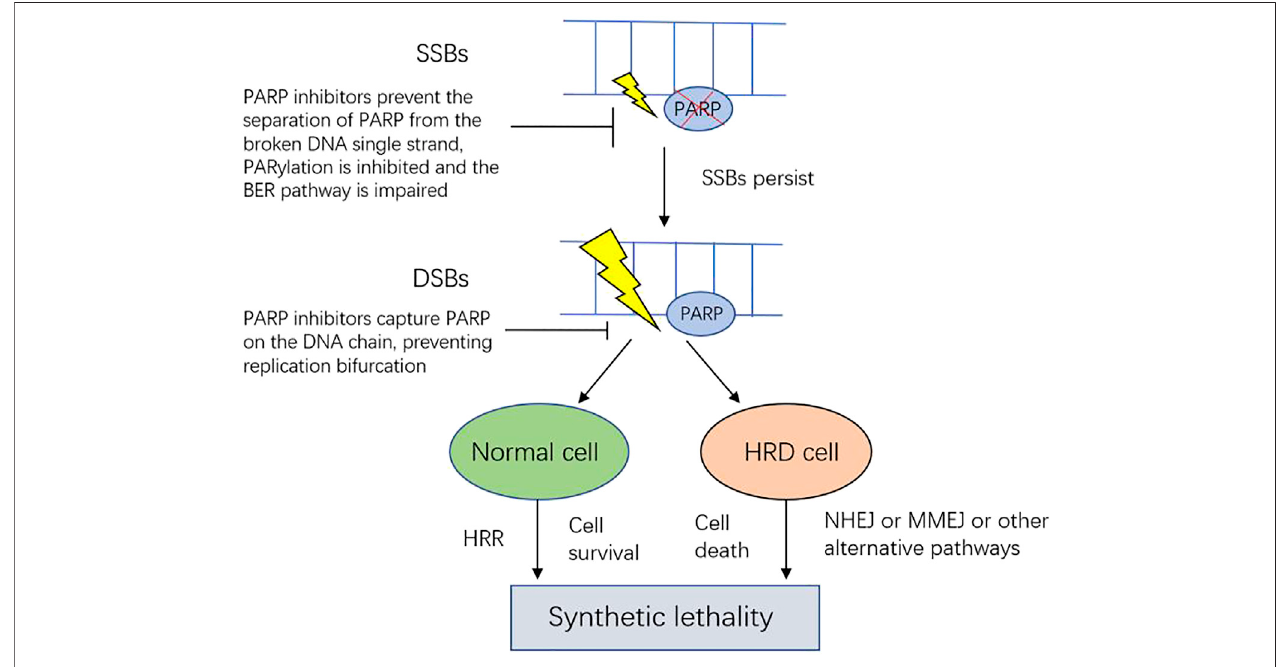
FIGURE2| MechanismofsyntheticlethalitybetweenHRDandPARPinhibitors.SSBsofDNAarenormallyef fi ciently repairedbyBER.PARPinhibitorspreventthe separation of PARP from the broken DNA single strand, PARylation is inhibited and the BER pathway is impaired, SSBs will persist. A replication fork may encounter persistent SSBs during DNA replication, which causes the replication fork to collapse or the formation of DSBs. DSBs are usually repaired by HRR, when some key homologousrecombination genesaredamagedordysregulated,HRDwilloccur.AndthenDNAcannotberequired, orisrepaired byalternativepathwaysthatare highly error prone, which results in gross genomic instability and cell death. SSB: single-strand breaks; DSB: double-strands breaks: BER: base excision repair; HRR: homologous recombination repair; HRD: homologous recombination de fi ciency; NHEJ: non-homologous end joining: MMEJ: microhomology-mediated end joining.